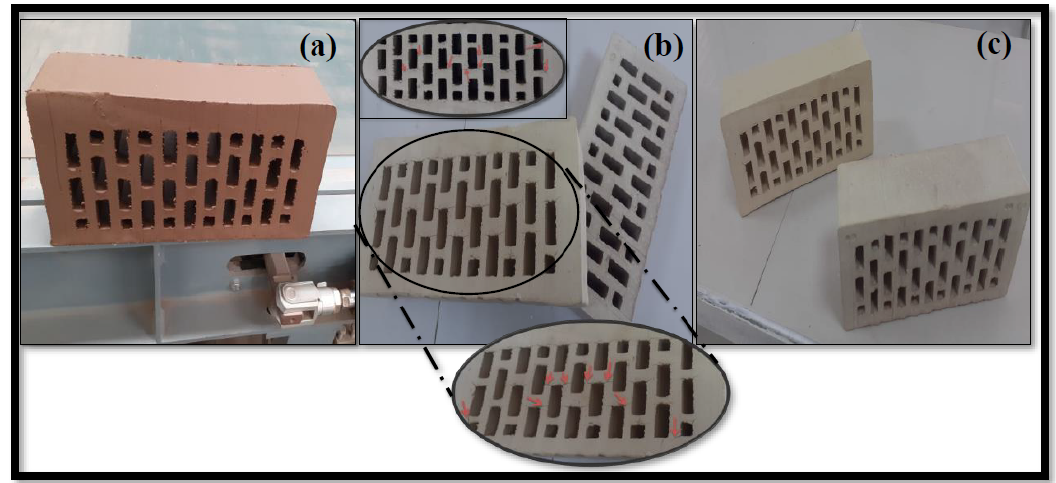
Figure 15. Industrial trial bricks of ( a ) DM, ( b ) HM, and ( c ) SM manufactured in the ceramic plant. Arrows showing the crack on HM bricks. Table 6. Technological features of fired hollow brick samples at 950 °C.